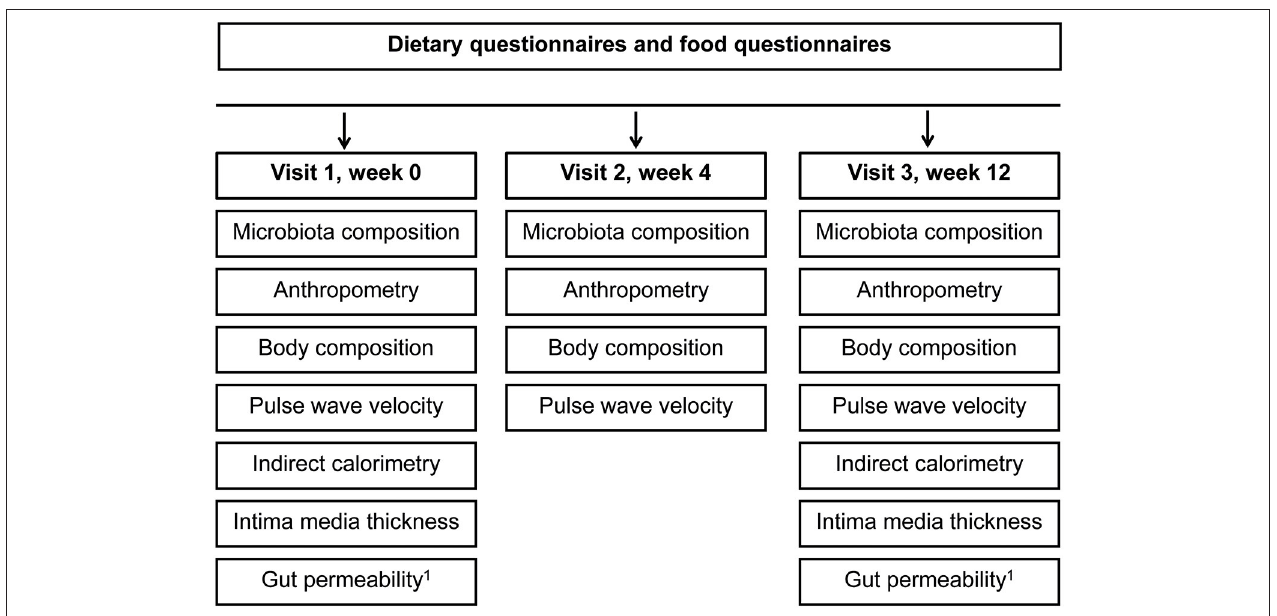
FIGURE 2 | Timeline and examinations. 1 Gut permeability was measured in a subgroup of participants ( n =